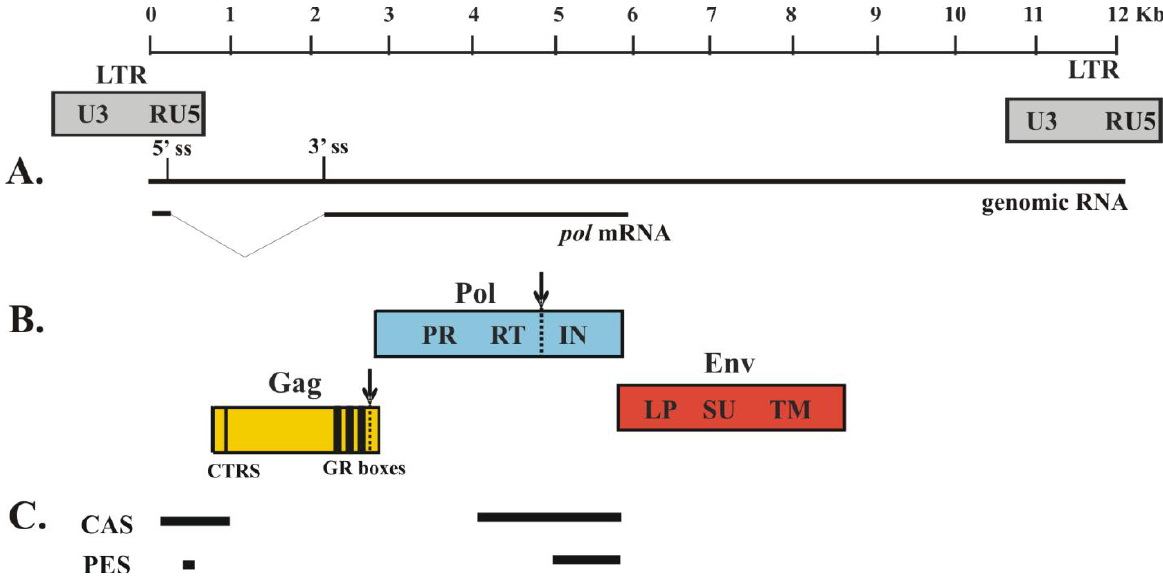
Figure 1. Genome of prototype foamy virus (PFV). Depicted is the molecular clone PFV-13 (GenBank accession no. U21247; 11,954 bases). The shaded boxes below the genome indicate the location of the LTR promoter regions in the proviral DNA. ( A ) The thin lines represent the genomic RNA and mRNA for Pol protein. Pol is expressed from a spliced mRNA. The 5´ splice site (ss) and the 3´ splice site (3´ss) are indicated. ( B ) The colored boxes indicate the three major PFV protein products: Gag, Pol and Env. PR-mediated cleavage sites are indicated with dashed lines and arrows. CTRS, cytoplasmic targeting and retention signal; GR boxes, glycine/arginine-rich motifs; PR, protease; RT, reverse transcriptase; IN, integrase. LP, leader peptide; SU, surface domain; TM, transmembrane domain. ( C ) The thick lines represent RNA sequences required for proper assembly. Cis -acting sequences (CAS) are required for genomic RNA packaging; Pol encapsidation sequences (PES) are required for Pol